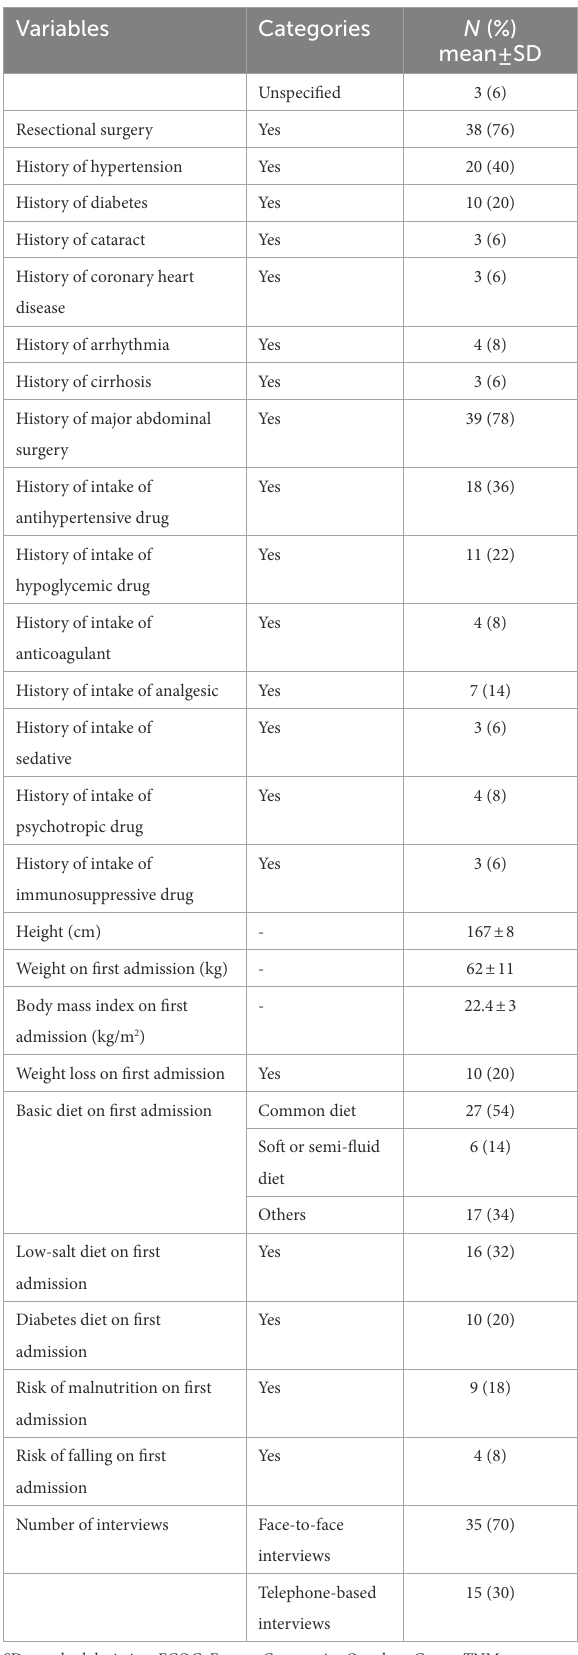
TABLE 1 Patient and tumor characteristics ( n =